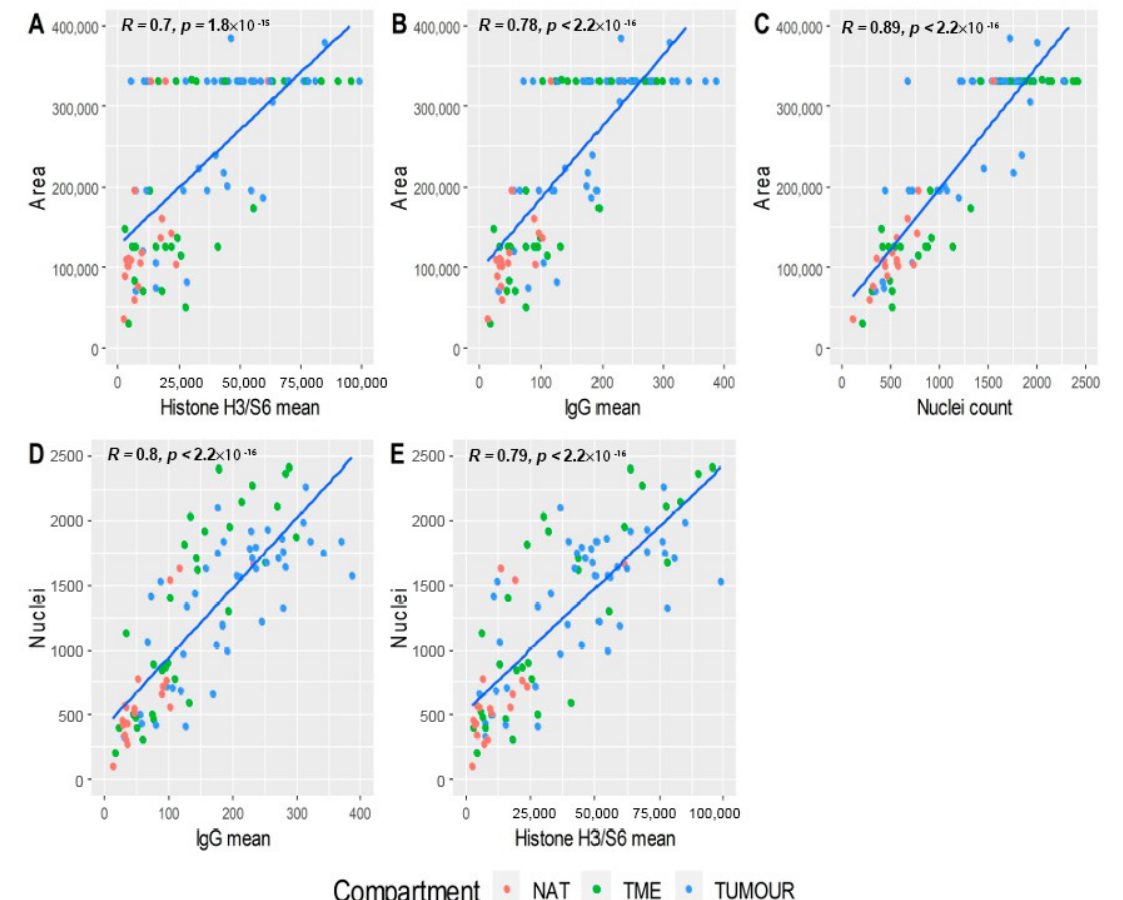
Figure 5. Assessment of ROI area and nuclei as normalisers. ( A ) ROI area was plotted against histone H3 / S6 means ( R = 0.7), ( B ) IgG means ( R = 0.78), ( C ) and nuclei counts ( R = 0.89). Nuclei counts were then evaluated against ( D ) IgG means ( R = 0.8) and ( E ) histone H3 / S6 means (R =